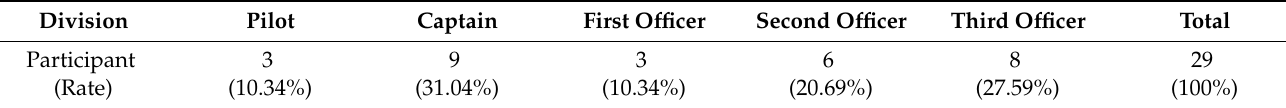
Table 2. Distribution of officers of the watch.